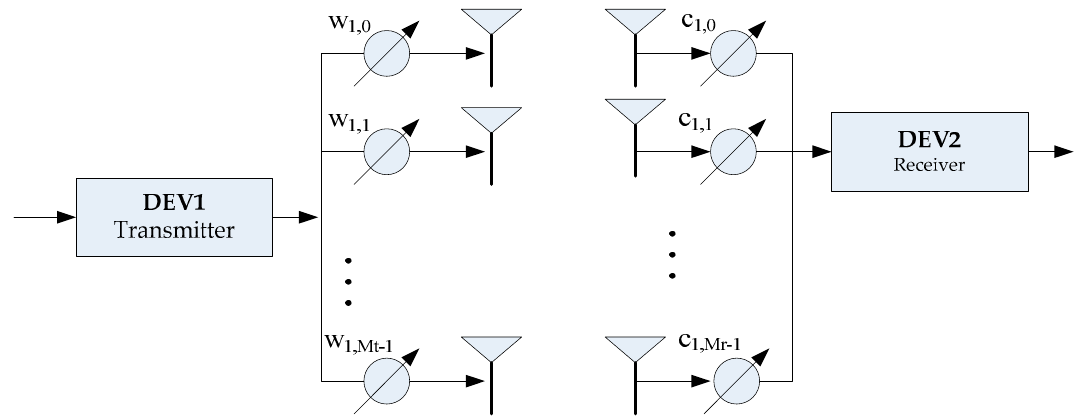
Figure 1. System model for beamforming (BF).